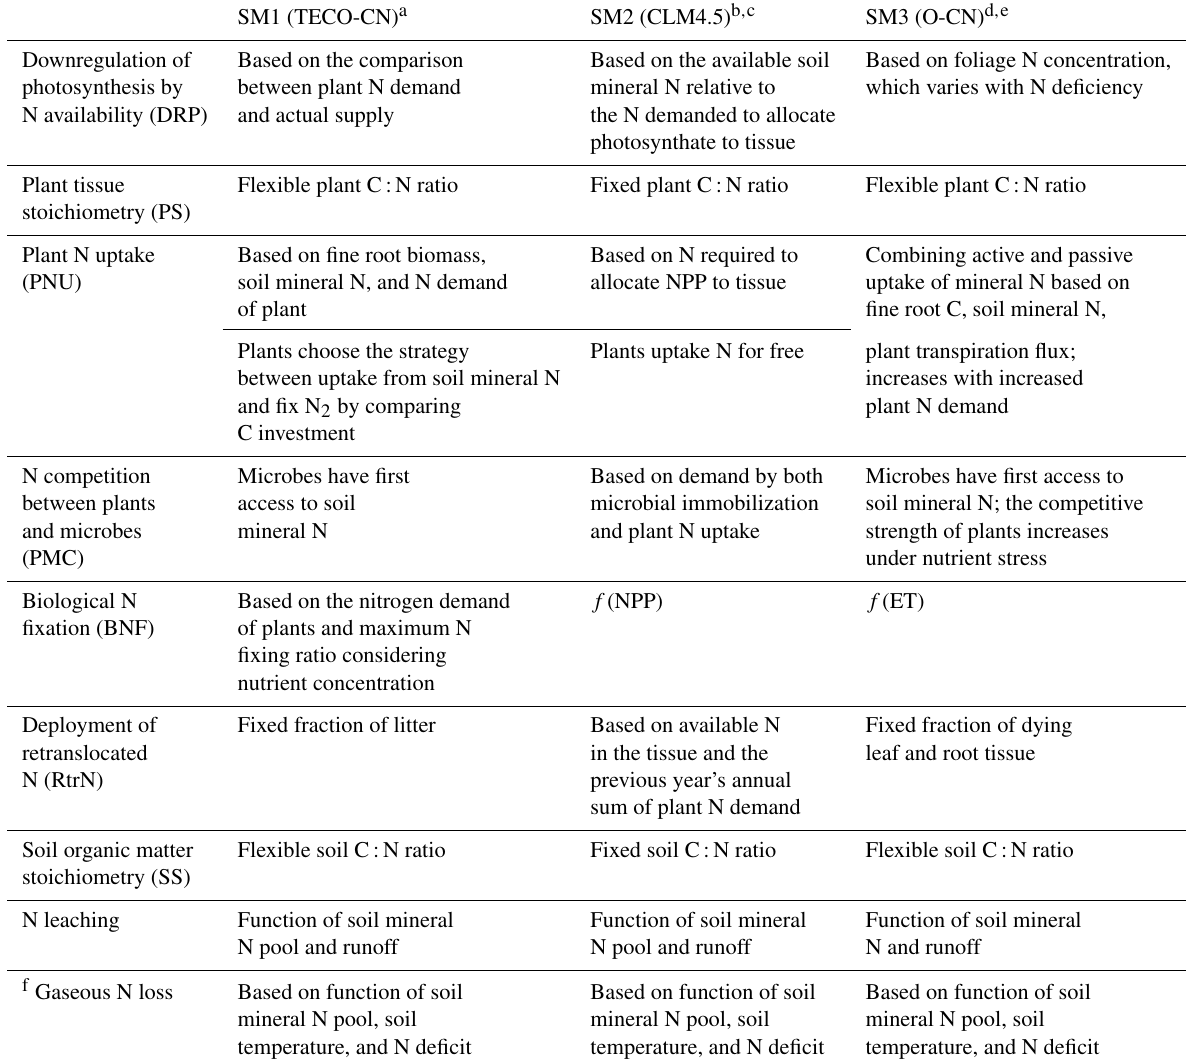
Table 1. Summary of the nitrogen–carbon coupling schemes used and the representation of key processes in the carbon–nitrogen cycle.